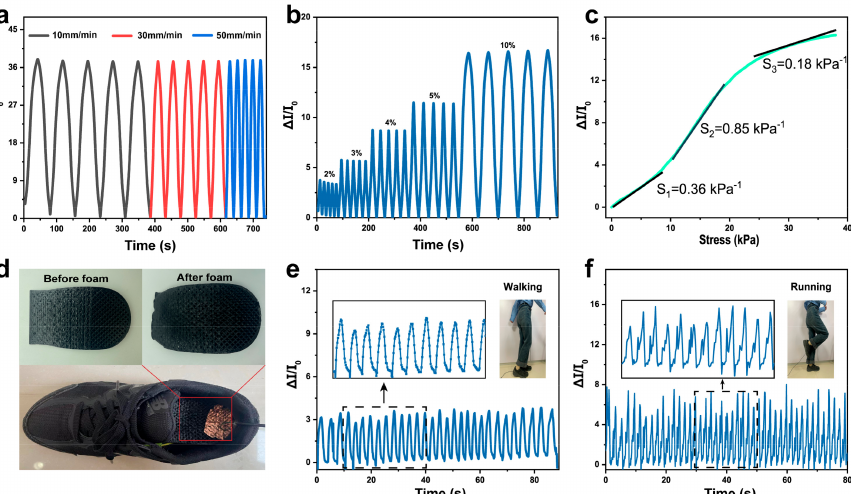
Figure 6. ( a ) Variation of relative current of TPU/4MWCNTs composite conductive foam at differ- ent compression rates; ( b ) variation of relative current of TPU/4MWCNTs composite conductive foam at small compression strains (2–10%); ( c ) pressure sensitivity of conductive composite foam; ( d ) TPU/4MWCNTs composite conductive foam as a plantar wearable sensor for gait recognition; and resistance responses for different gait patterns: ( e ) walking and ( f )